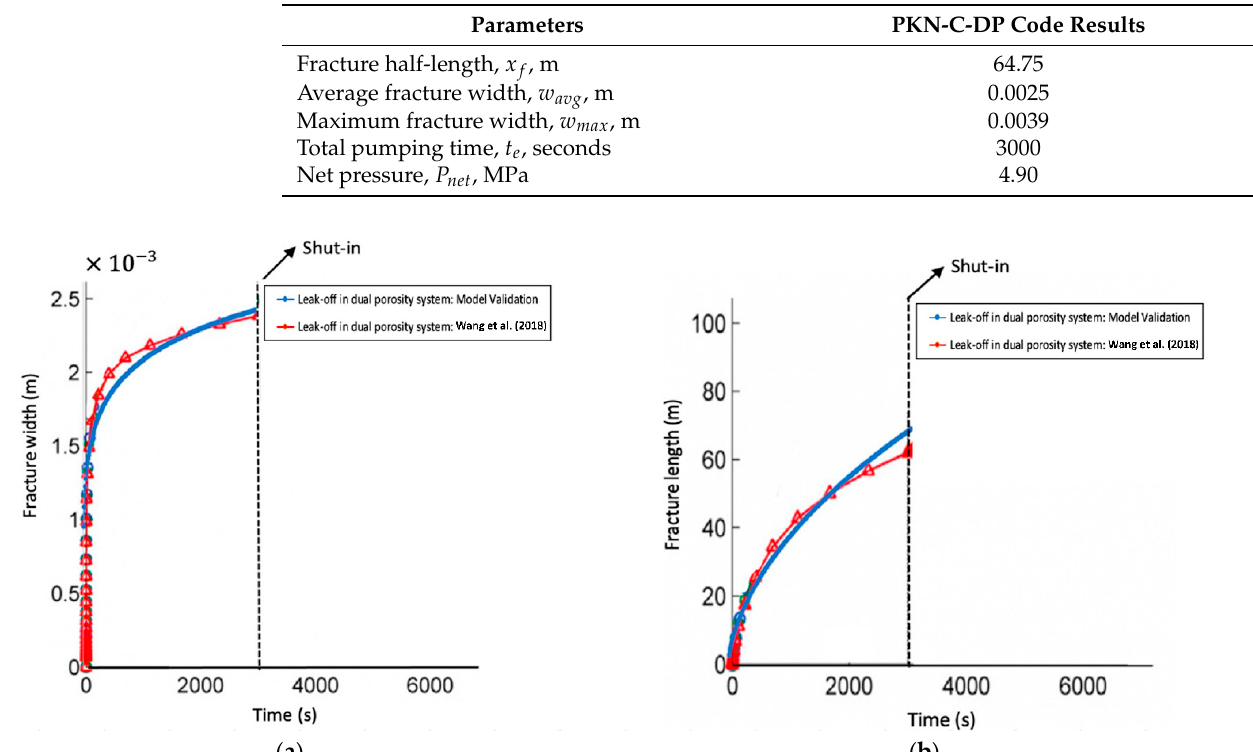
Table 2. Model validation results for the PKN-C-DP code.